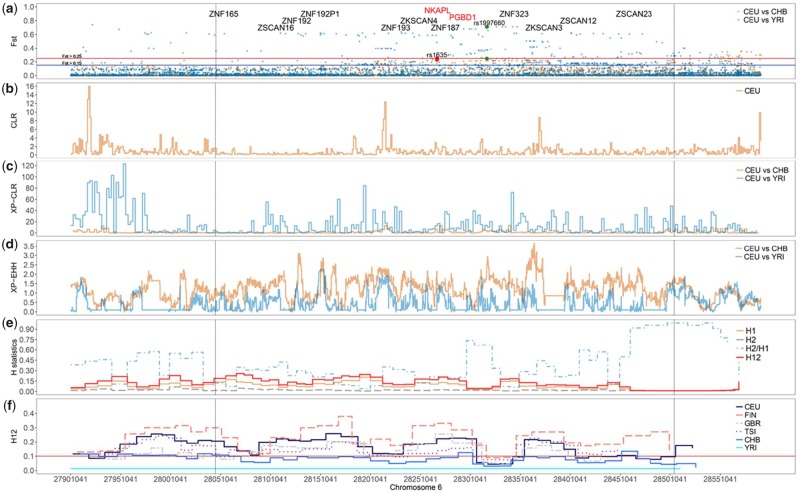
—KRAB-ZNF gene cluster located on the chromosome 6 of four European population (6: 28.04–28.42) exhibiting very high genetic differentiation (a), high CLR (b) and XP-CLR (c) scores, long EHH (e, f) and multiple high frequency haplotypes. Note that the scale on the y axis differs between plots. All values correspond to the raw scores obtained for each method. In the FST track (a), SNPs over the solid lines indicating moderate (FST > 0.15, blue line) and high (FST > 0.25, red line) genetic differentiation. Bigger dots indicate two highly differentiated SNPs, rs1635 (CEU vs. CHB, red) and rs1997660 (CEU vs. YRI, green). H12 track statistics (e) shows the H scores for: homozygosity of the most frequent haplotype (H1), homozygosity calculated using all, except the most frequent haplotype (H2), the ratio between H2/H1, and the combination of the most and second most frequent haplotypes (H12). In H12 track (f) for four populations with European, one with Asian and one with African background. The H12 threshold we defined genome wide (solid red line, 0.1). Dotted vertical line indicate extension of positively selected region within this KRAB-ZNF cluster.